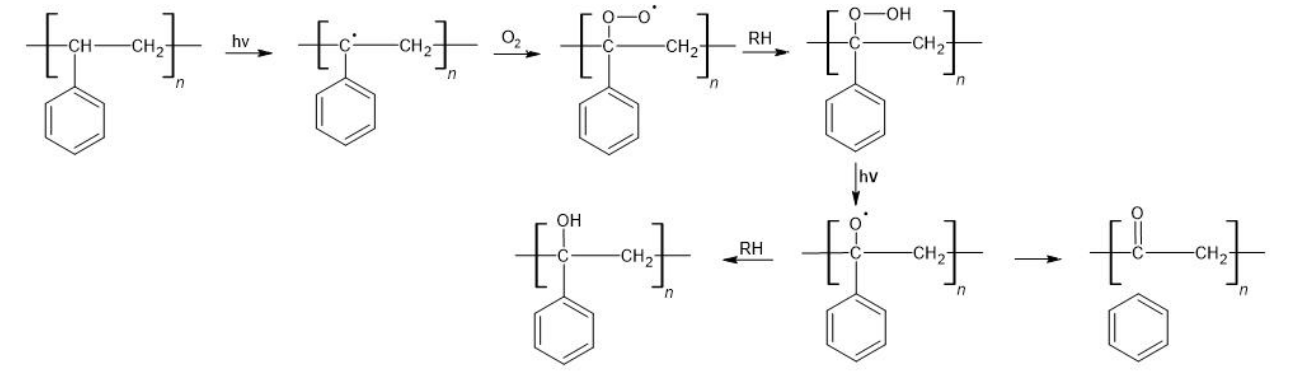
Figure 5. Photodegradation of PS (hν — to add energy via photons, RH —inclusions).